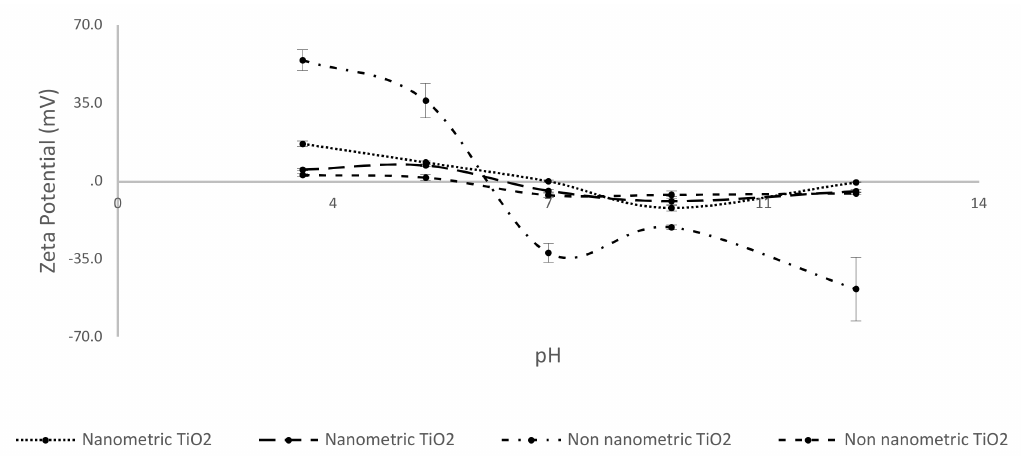
Figure 7. Z potential behavior for each kind of TiO 2 coated and